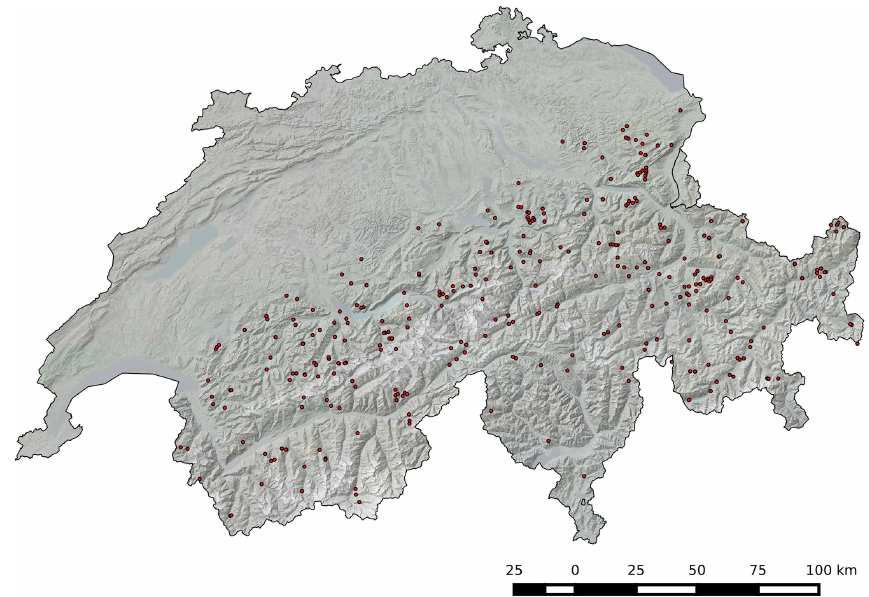
Figure 1. Locations of 297 webcams (red points) in the Swiss Alps. Background data: SWISSIMAGE 25 and DHM25/200, © swisstopo.